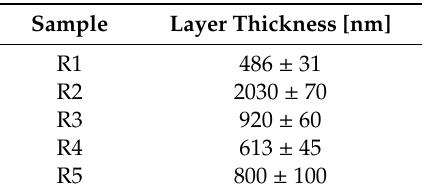
Table 2. Thickness of the RPTMS layers.